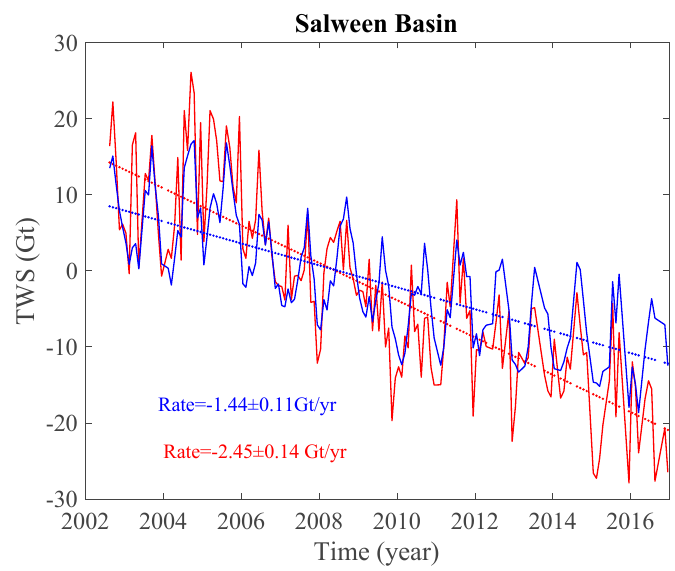
Figure 9. Time series of water storage variations in the Salween basin from August 2002 to December 2016. For an explanation of rates, see the legend in Figure 4.